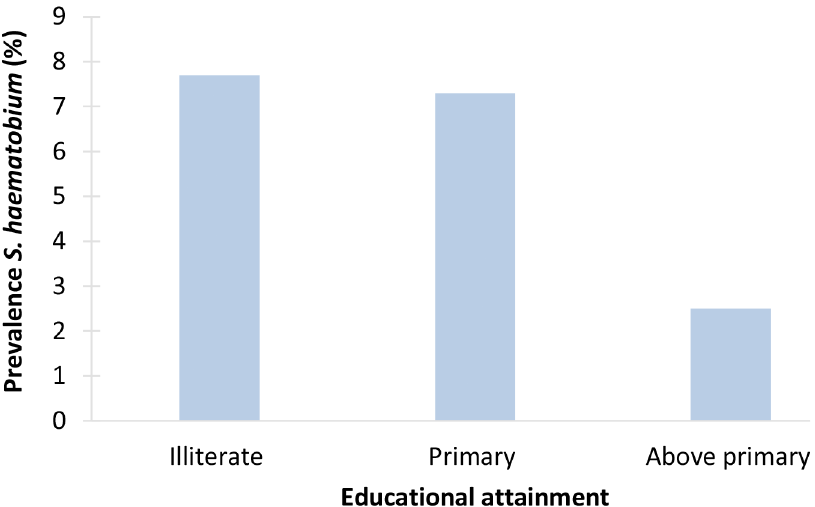
Fig 8. Example of socioeconomic inequalities in schistosomiasis: association between S . haematobium prevalence (%) and educational attainment in South Kordofan State, Sudan (2009) [6]. South Kordofan State is located in the south of Sudan, bordering South Sudan. A total of 1,826 adults (aged > 18 years) were recruited from all nine localities (36 villages or towns) of South Kordofan State. Urine samples were examined for the presence of S . haematobium , and a questionnaire on demographics and economic status of the family head was administered. Overall prevalence of S . haematobium eggs was 6.9%. Infection prevalence was higher among people with a lower educational